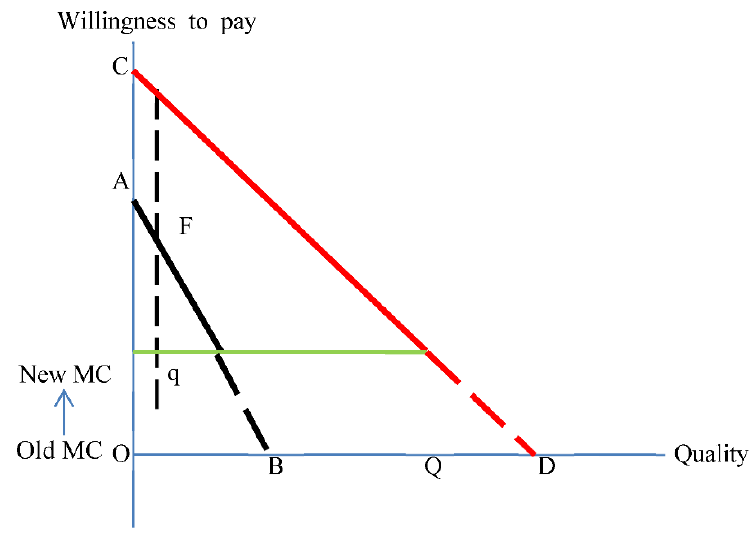
Figure 4. China’s real property